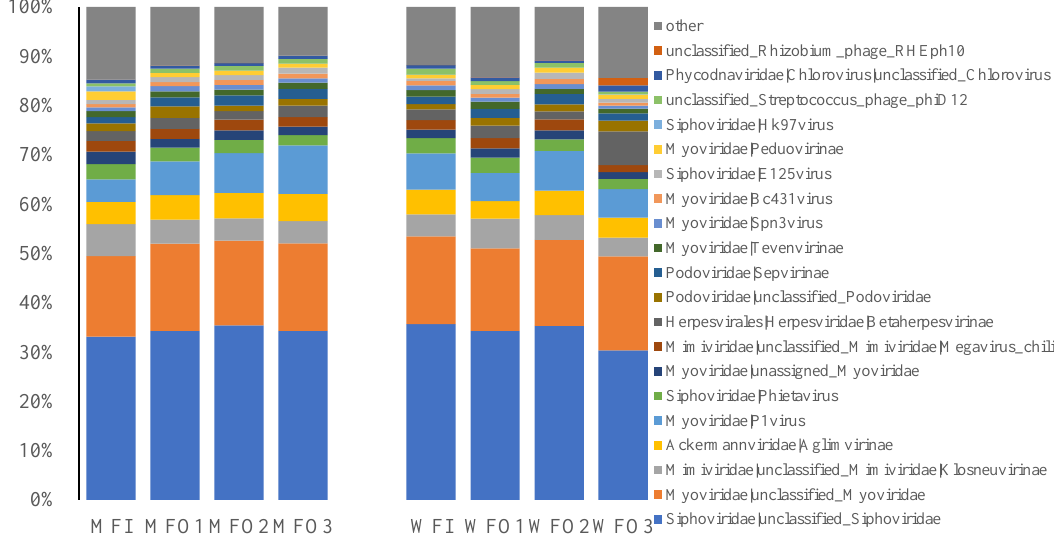
Figure 5. The relative abundance of the dominant viral families in each well.